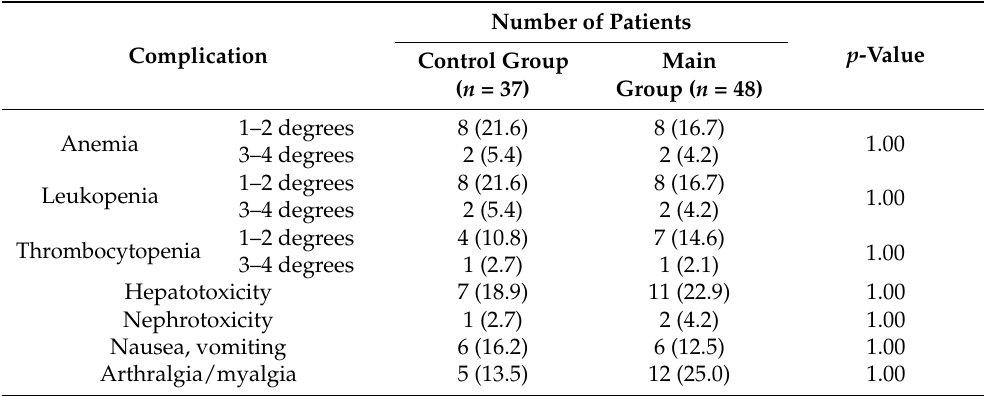
Table 1. The frequency and nature of adverse events during chemotherapy in patients with non- small-cell lung